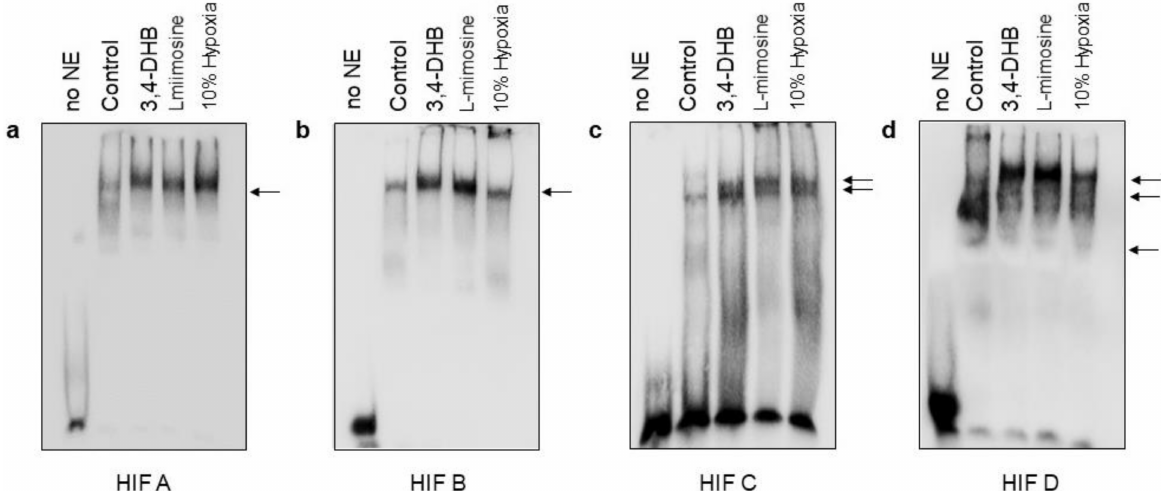
Figure 10. Evaluation of the putative HRE binding sites of the MORG1 promoter region by EMSA. HEK 293 cells were exposed to 10% hypoxia or treated with 3,4-DHB and L-mimosine for 12 h followed by isolation of nuclear protein extracts (NE). The binding reactions between NE and double stranded 3 (cid:48) -Biotin 11–UTP labeled specific sequences corresponding to the putative MORG1 promoter HRE binding motifs termed HBS A, HBS B, HBS C and HBS D were performed and separated on a 6% non-denaturing PAGEs. Representative images are shown. ( a ) HBS A. ( b ) HBS B. ( c ) HBS C. ( d ) HBS D. At least two experiments with qualitative similar results per binding site were performed. The development of the membranes revealed that in all HBS of the h MORG1 promoter shifted bands were detected compared with the labeled oligos without NE (no NE lane on the images), thus shown a binding between nuclear proteins (transcription factors that bind to ds DNA sequences) and the analyzed ds sequences. The detected bands are shown with arrows on the